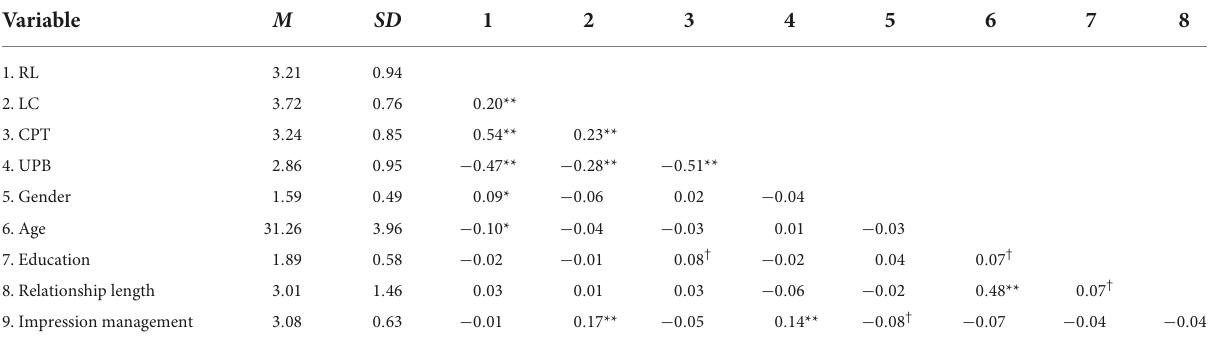
TABLE 3 Means, standard deviations, and